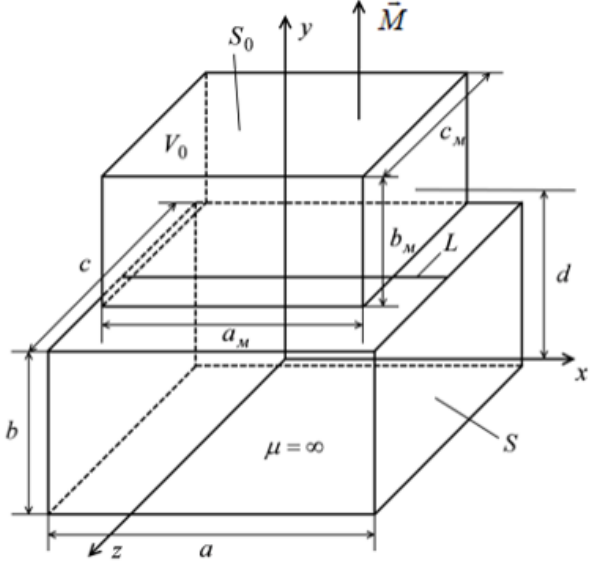
Figure 7. The magnetic field of the system for which the calculation was made using integral equations of the first kind.